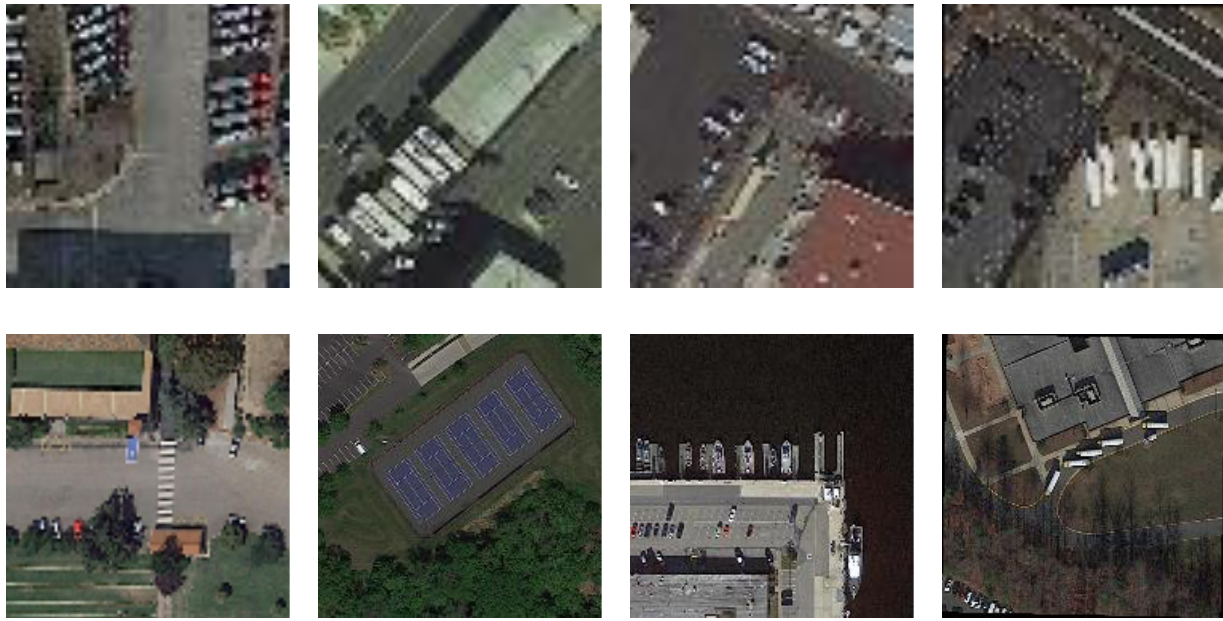
Figure 4. Examples of images from the data set. Images contain vehicle_1 and vehicle_2 objects, as well as roads, trees, houses and other kinds of backgrounds.